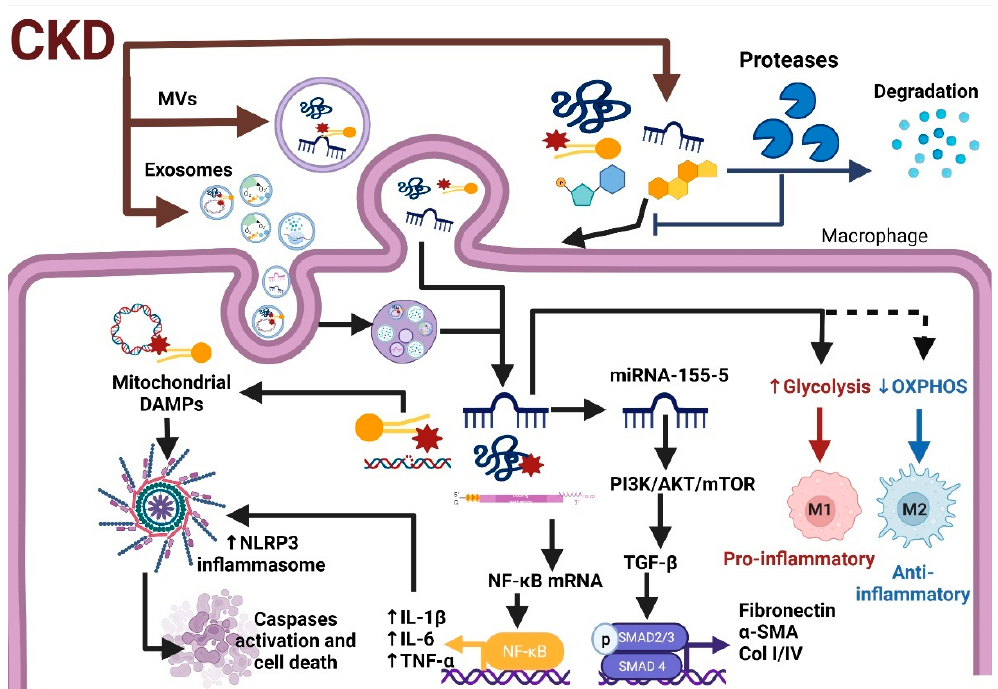
Figure 6. Extracellular vesicles’ (EVs) role in the promotion of inflammation and fibrosis in CKD. Exosomes and microvesicles (MVs) secreted in CKD are enriched with pro-inflammatory factors such as transforming growth factor-beta 1 (TGF- β 1) and nuclear factor kappa-light-chain-enhancer of activated B cells (NF- κ B). These two factors are the main drivers of inflammation and fibrosis in CKD. Once these EVs are internalized in recipient cells such as macrophages, they increase pro-inflammatory cytokines such as tumor necrosis factor-alpha (TNF- α ), interleukin-1 beta (IL-1 β ), and interleukin 6 (IL-6). Furthermore, mitochondrial DAMPs released by EVs trigger NLR family pyrin domain containing 3 (NLRP3) inflammasome activation and cell death. In addition, miRNA and metabolites released by exosomes induce metabolic reprogramming of macrophages to glycolytic M1 type, the pro-inflammatory type, reducing oxidative phosphorylation system (OXPHOS)-based M2 macrophages, the anti-inflammatory M2 type. Image created with Biorender.